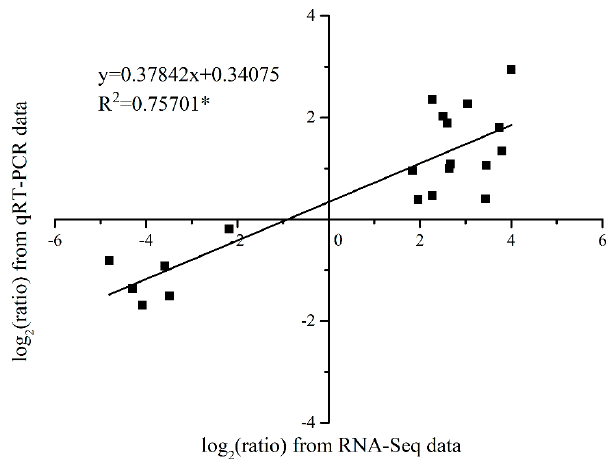
Figure 10. Coefficient analysis of fold changes data between qRT-PCR and RNA-Seq. Scatter plots represent the fold-changes in the gene expression levels of the senescing panicle leaves compared to those of the developing panicle leaves. All the data are from the qRT-PCR analysis and RNA-Seq of the DLE, DLL, SLE, and SLL. Asterisk indicates that the slope is significantly different from zero at 0.05 probability level.